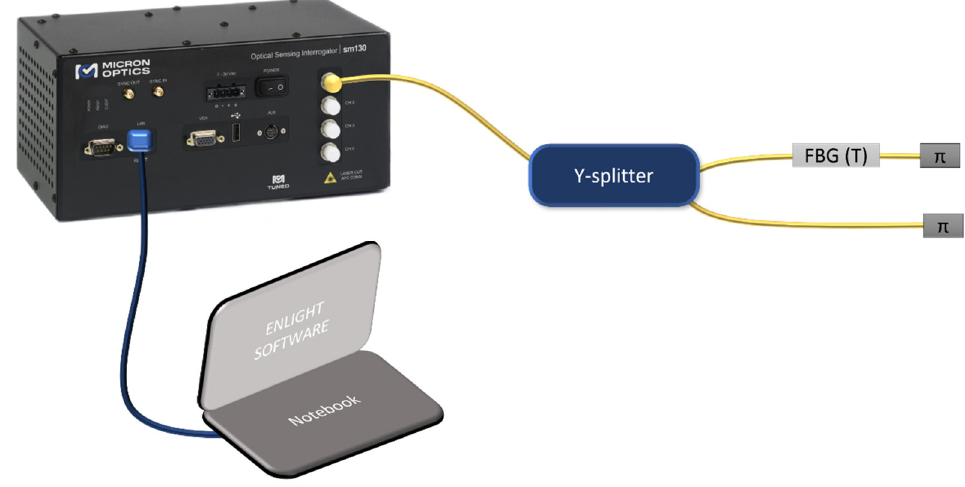
Figure 4. Experimental setup for the connection of 2 π probes on the same interrogation channel.